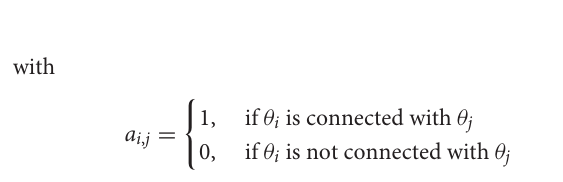
FIGURE 8 | Sparse interaction scheme for the Kuramoto model [Equation